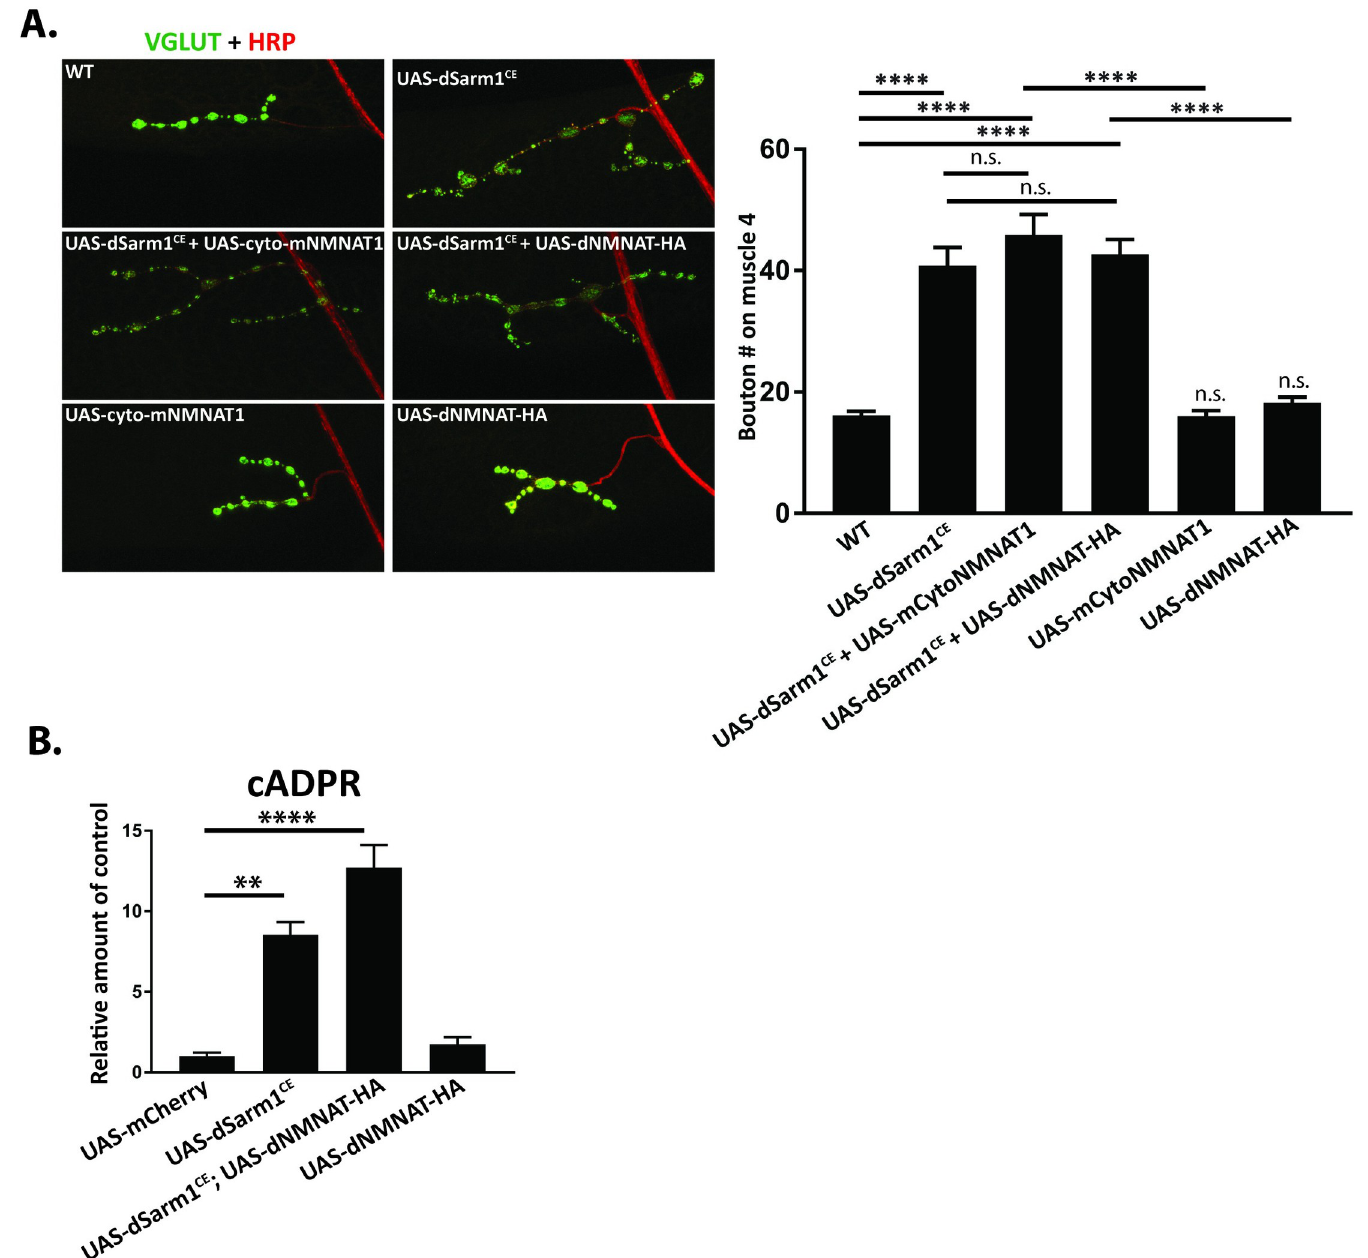
Fig 4. dSarm1 is activated by distinct signals during NMJ growth and in axon injury. Activation of dSarm1 for NMJ growth and axonal injury appears to be unique. A , In uninjured animals, overexpression (dVGlut-Gal4) of either cyto-mNMNAT1 or dNmnat does not block NMJ overgrowth due to dSarm1 CE (isoform E-3kb) overexpression. Representative confocal images of muscle 4 synapses from third instar larva co-stained for presynaptic dVGlut (green) and neuronal HRP (Red). Quantification of the bouton number from motoneuron MN4b on muscle 4 of male progeny (16.1, 40.8, 45.9, 42.7, 16.0, 18.2), respectively ( ���� p < 0.0001)). (n = 23, 18, 27, 33, 24, 21). B, The ventral nerve cord from third instar larva expressing individual transgenes were dissected and metabolites were extracted for mass spectrometry. Transgenes (isoform E-3kb) were expressed under control of the pan-neuronal driver BG380-Gal4. cADPR levels were measured as a biomarker for Sarm1 NADase activity. Quantification of cADPR levels are (1.00, 8.54, 12.70, 1.75 fold, respectively) (n = 7 for each genotype). For Fig 4A and 4B, values are presented as mean +/- SEM. Statistics were obtained by performing a one-way ANOVA with Tukey’s multiple comparisons for genotypes. ( �� p < 0.01 and ���� p < 0.0001).